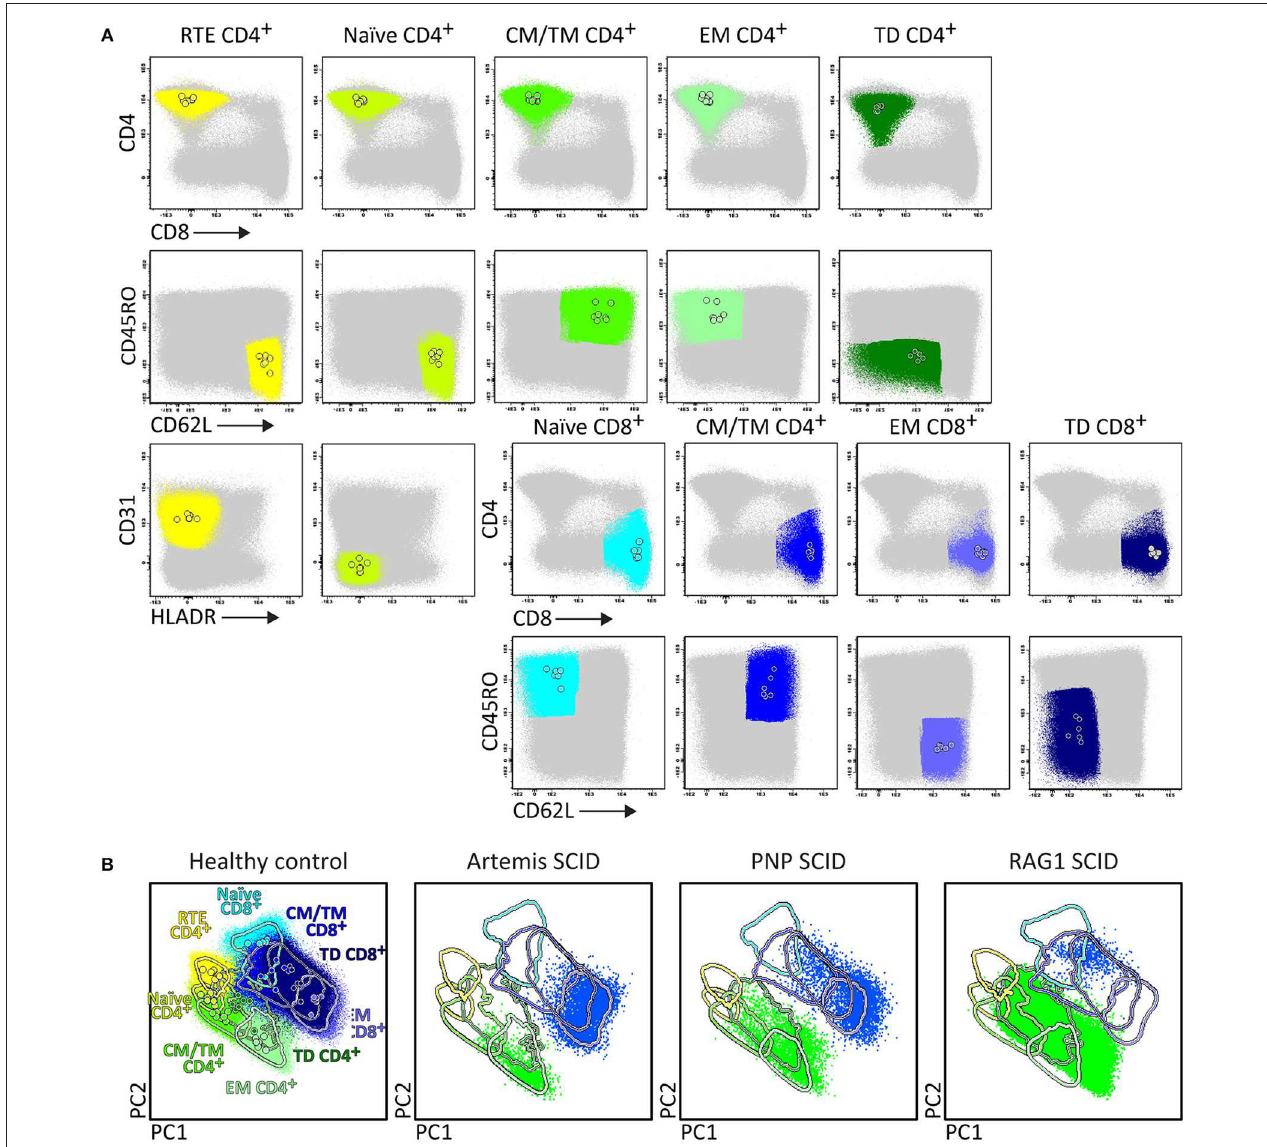
FIGURE 6 | Application of the RTE-SCID tube in healthy controls and T-cell defects. Analysis of circulating T-cell subsets (FS/SS lo CD3 + ) identified within 1x10 6 blood leukocytes using the markers from the RTE-SCID tube: Recent Thymic Emigrants (RTE) CD4 + T-cells (CD4 + CD8 − CD45RO − CD62L + CD31 + HLA-DR − ), and naïve (CD45RO − CD62L + CD31 + HLA-DR − ), Central/Transitional Memory (CM/TM) (CD45RO + CD62L + ), Effector Memory (EM) (CD45RO + CD62L − ), and Terminally Differentiated (TD) (CD45RO − CD62L − ) CD4 + and CD8 + T-cells. (A) The identification of biologically relevant T-cell subsets in six healthy controls using the minimum number of bivariate plots required for a 6 marker-combination (three bivariate plots/cell population). (B) Comparable T-cell data via PCA1 vs. PCA2 representation of a 6-dimensional space in six healthy controls (left) as well as in three severe combined immunodeficiency (SCID) patients, diagnosed with Artemis, PNP and RAG-1 defects, all stained with the RTE/SCID tube under comparable conditions. All three SCID patients show “leakiness” with virtually complete absence of naïve T-cells ( < 1 cell/ µ L blood) and clear “right shift” to mature CM/TM, EM, and TD T-cells in both the CD4 and CD8